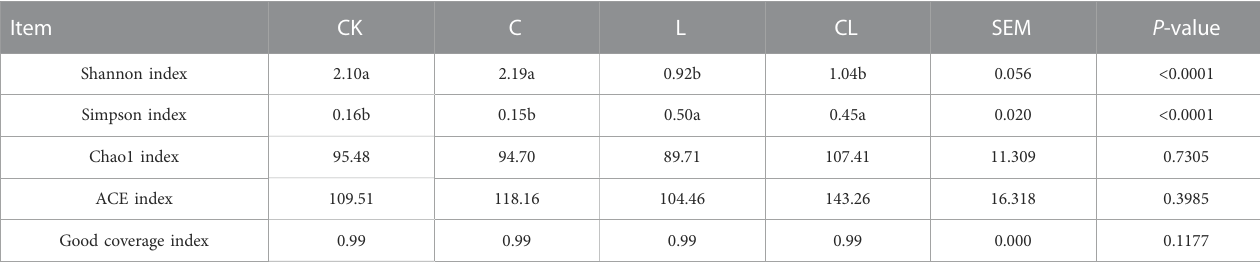
TABLE 4 The microbial α -diversity of Caragana korshinskii silage after 56 days of ensiling. Item